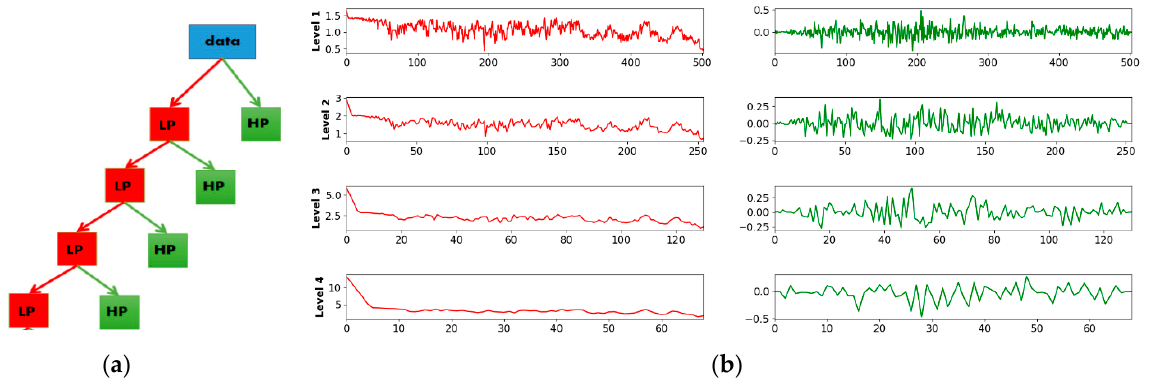
Figure 6. Discrete Wavelet transform (DWT) application: ( a ) Schematic dyadic tree ( b ) Approximation and Detail coefficients for a sample dataset.